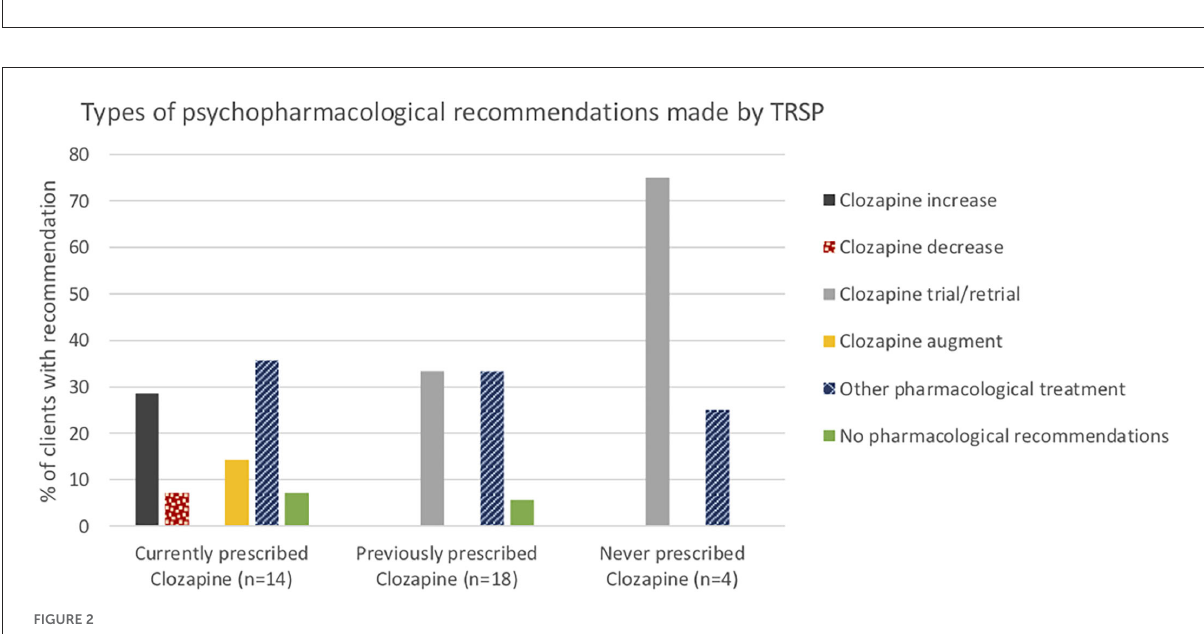
FIGURE2 Types of psychopharmacological recommendations made by